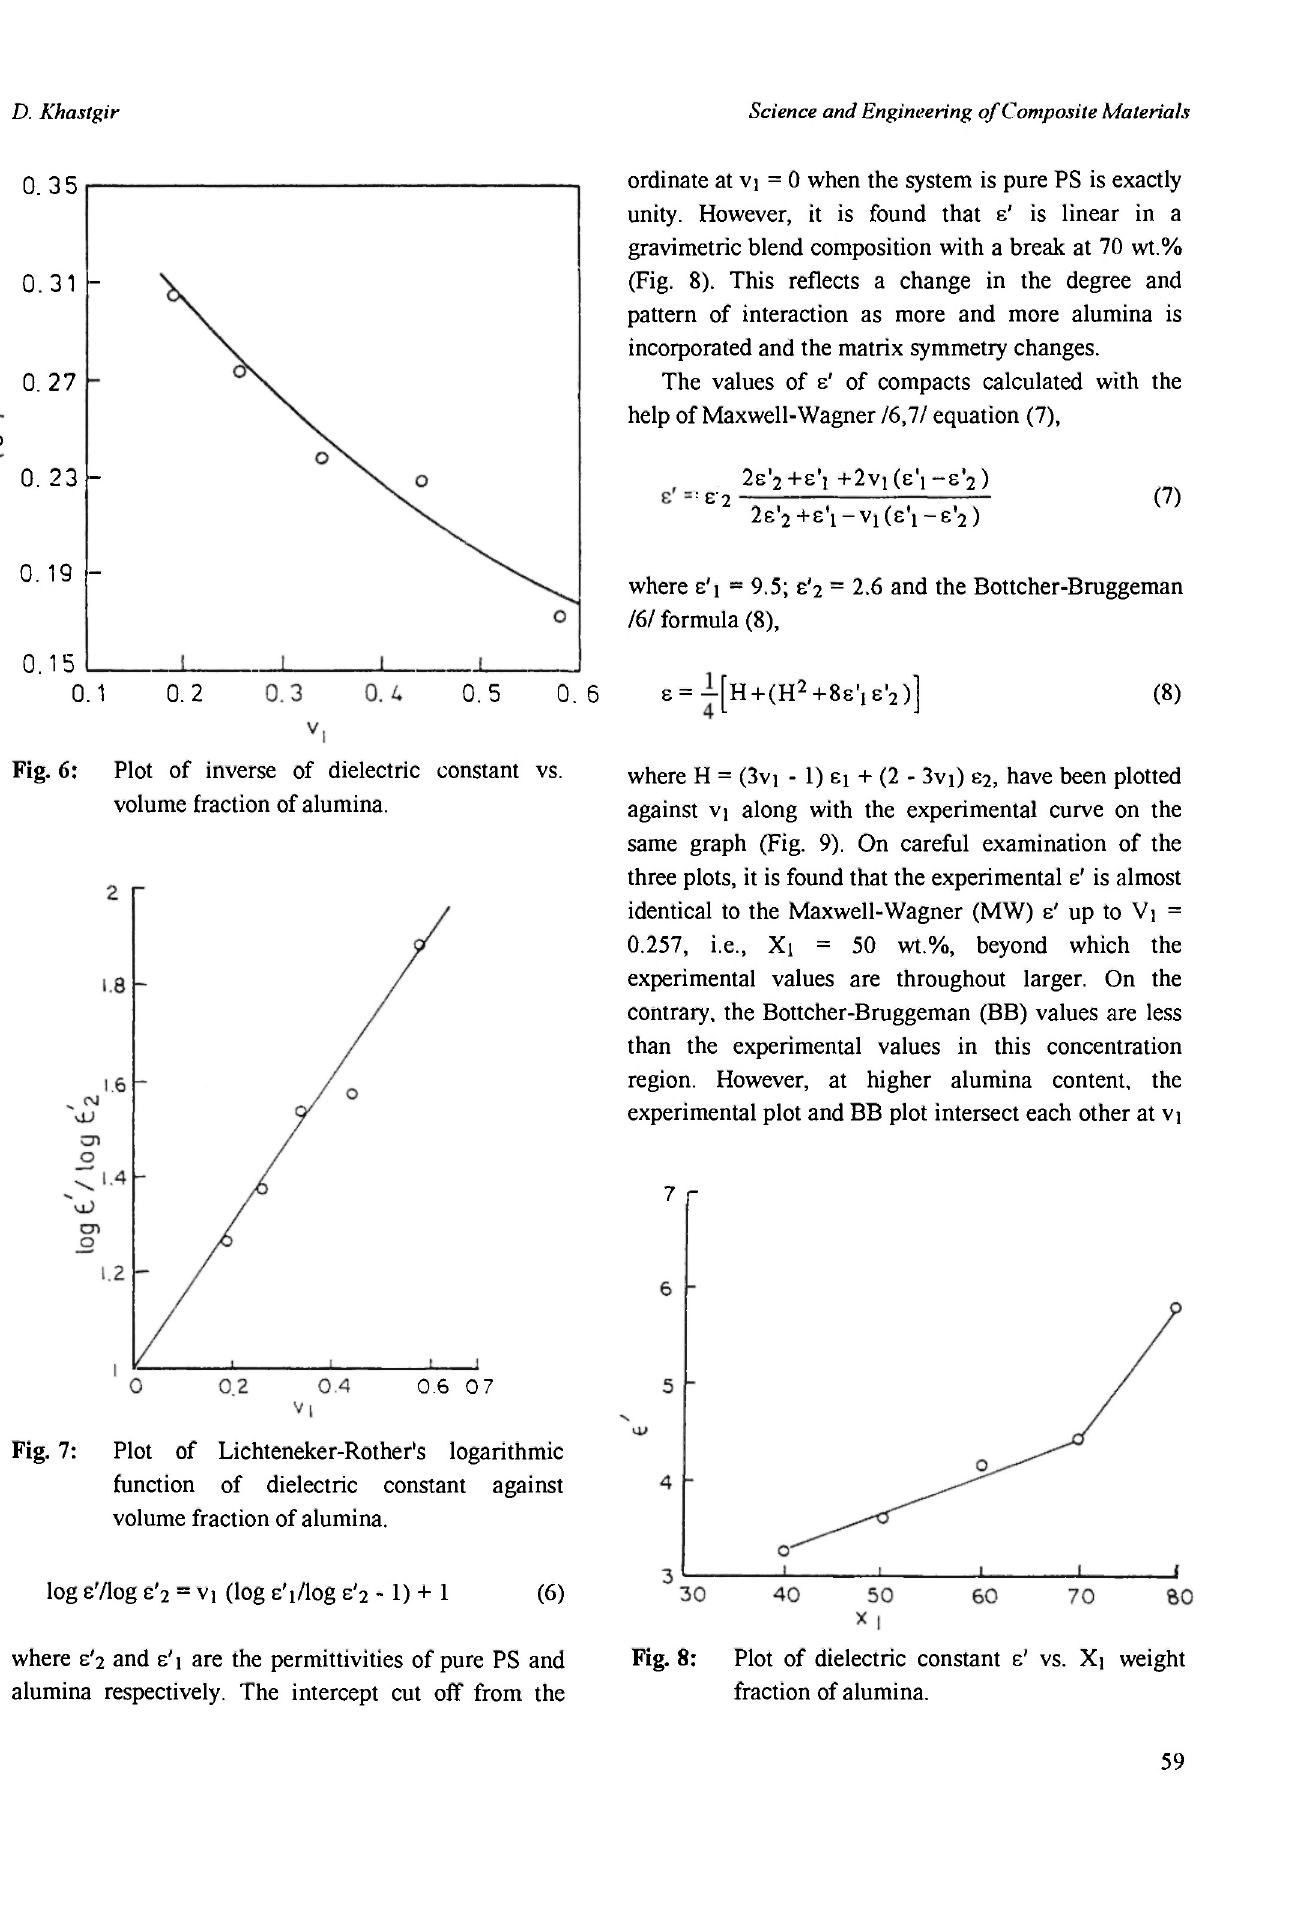
0.6 07 Plot of Lichteneker-Rother's logarithmic function of dielectric constant against volume fraction of alumina.